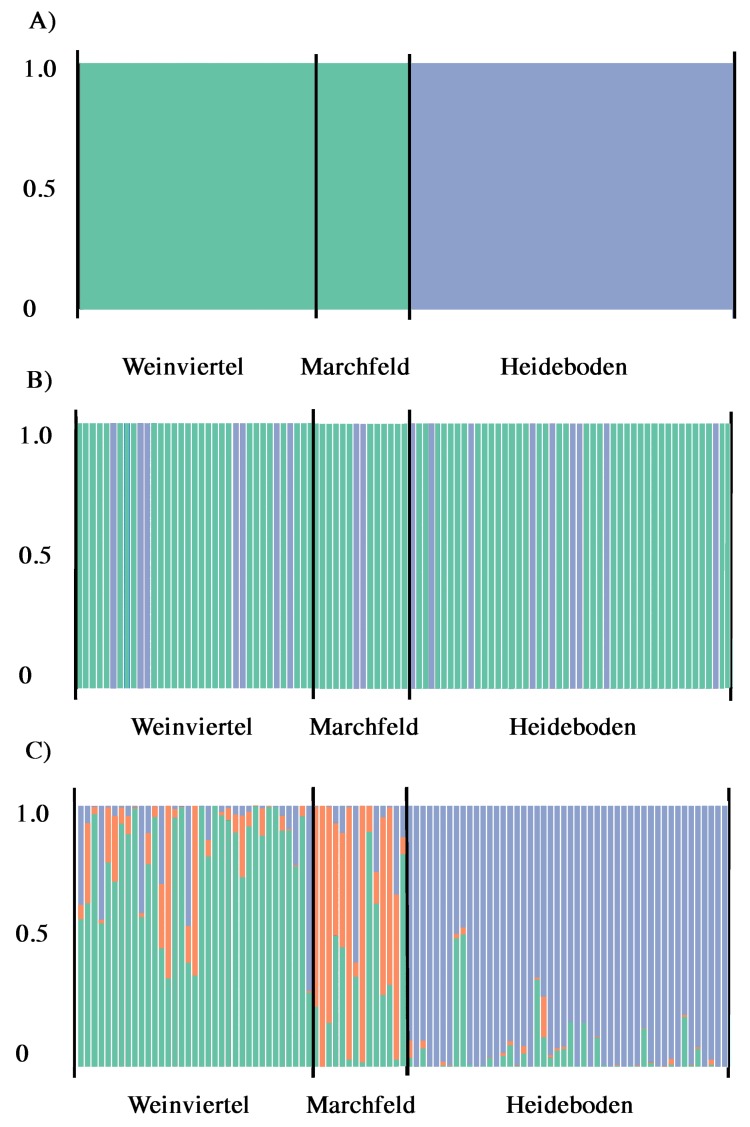
Output of BAPS (A) and DAPC analysis with (B) and without (C) the find.clusters function showing the membership fraction (columns) of the inferred genetic units for West-Pannonian Great Bustards in each individual of the three studied breeding areas.Same colour in different individuals indicates that they belong to the same cluster.